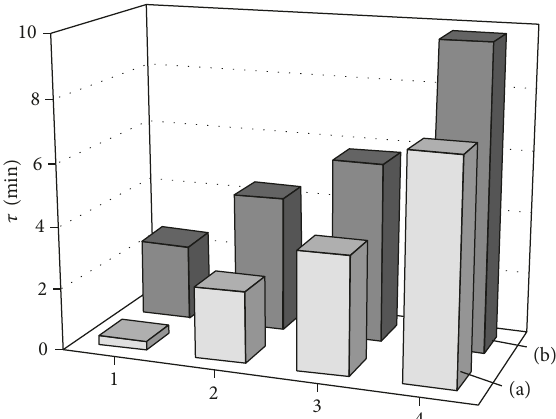
Figure 7: Stages of polymerization of VV0 -PVP-gr-PMMA compositions depending on comonomer nature: ( 1 ) without comonomer; ( b ) HEMA. Comonomer content: 20% (mas.). 1: sandy stage; 2: sticky stage; 3: dough-like stage; 4: viscous